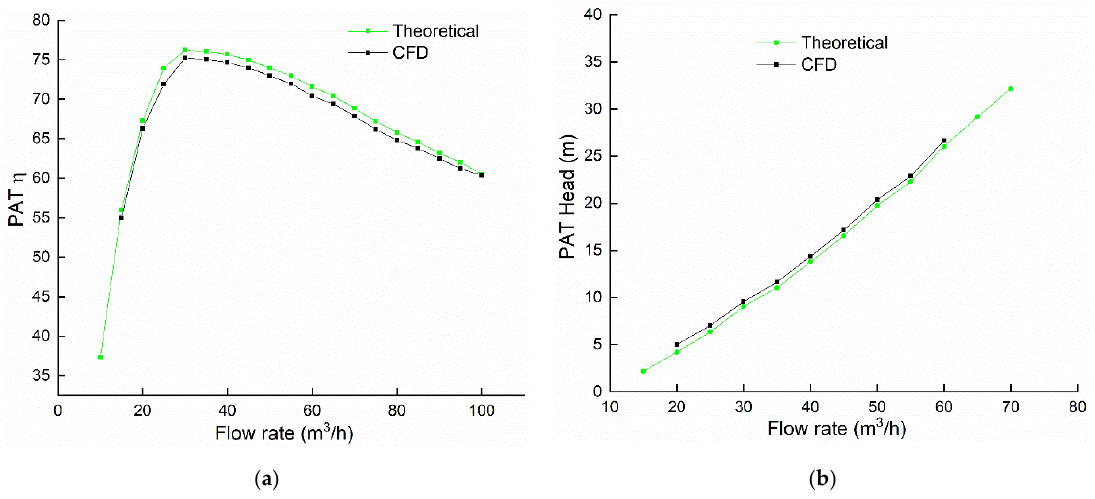
Figure 16. Prediction performance of PAT for ( a ) turbine mode efficiency ( b ) turbine mode head.